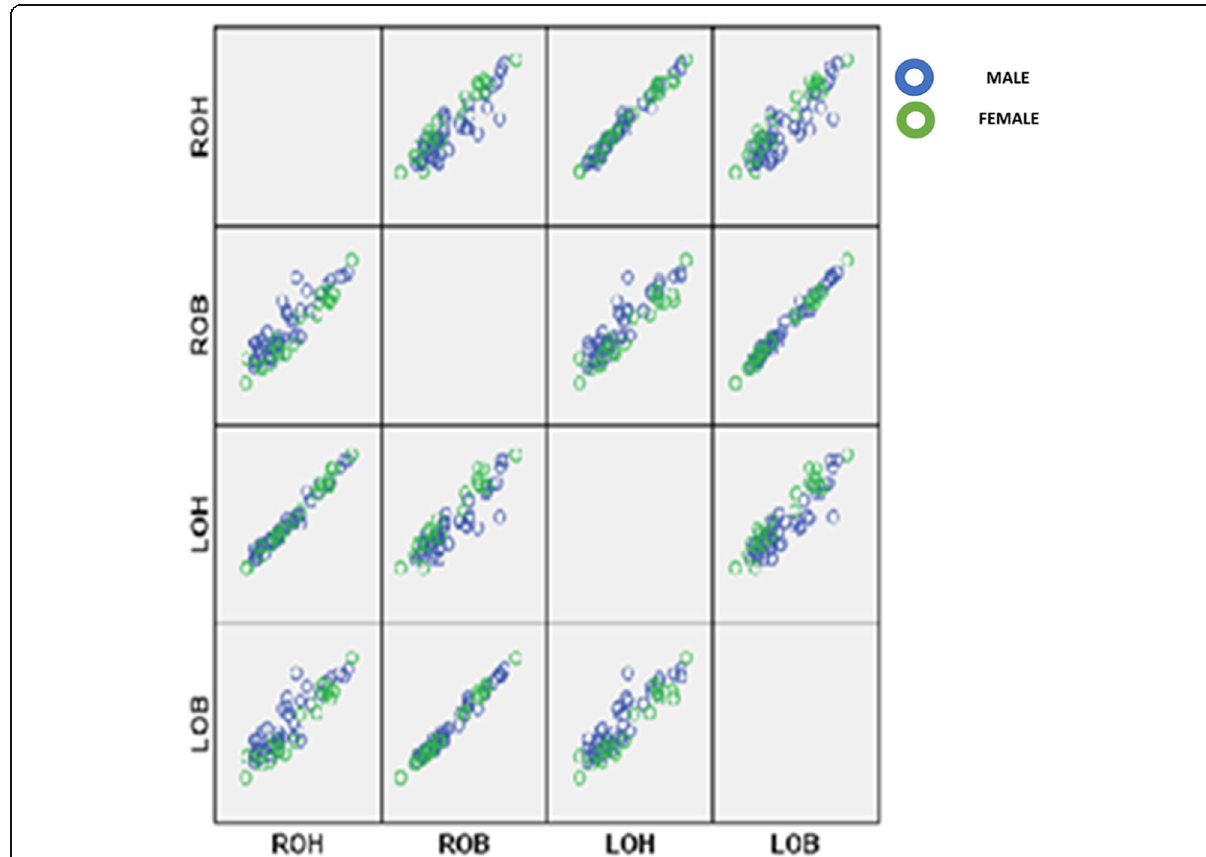
Fig. 4 The scatter matrix plot of the variables used to predict sex. (ROH right orbital height, ROB right orbital breadth, LOH left orbital height, LOB left orbital breadth. Blue dots indicate male. Green dots indicate female scale type